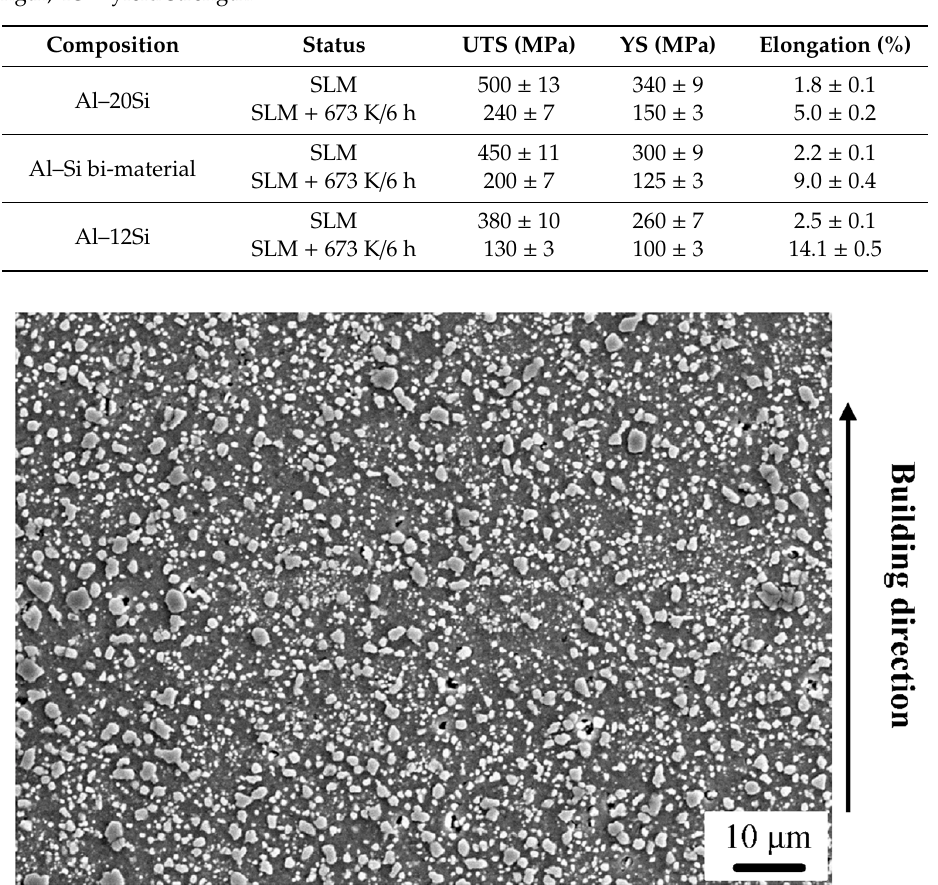
Figure 8. Microstructure of the Al–(12-20)Si bi-material after heat treatment at 673 K for 6 h.